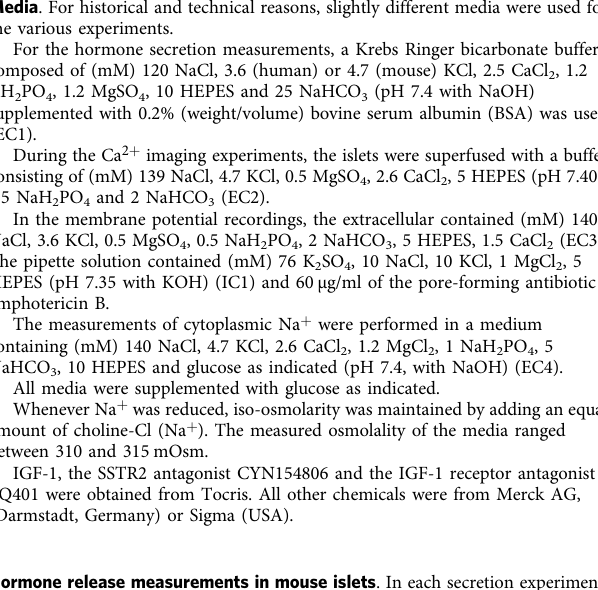
The mice were kept at constant temperature (22 °C) and 12-h light/dark cycles. They had free access to a standard chow diet (B&K) and water ad libitum.